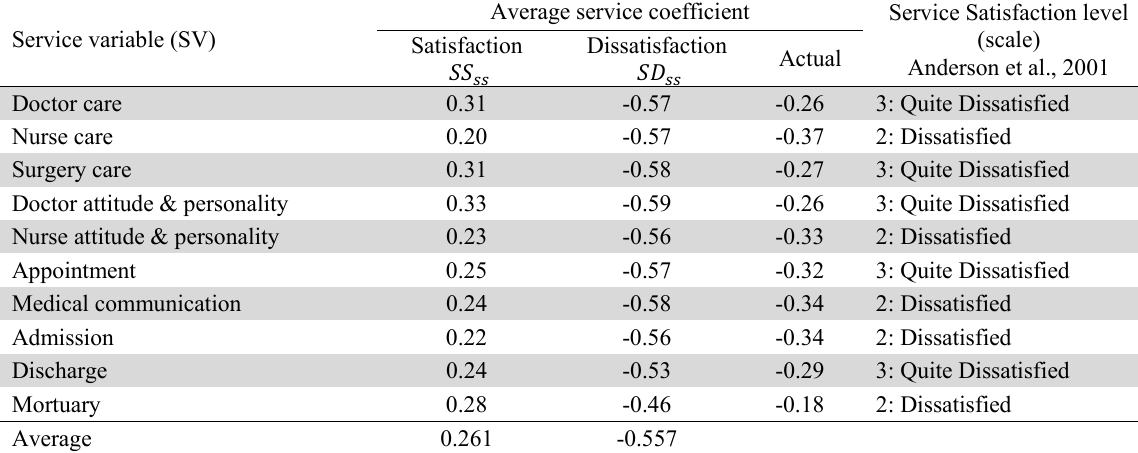
Average service